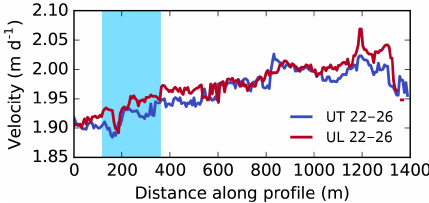
Figure 9. Comparison between two velocity fields obtained from different flight paths at comparable times between 22 and 26 July 2017. The blue shading marks where the transect crosses Lake 031. The transect is visualized as transect F9 in Fig. 1c.